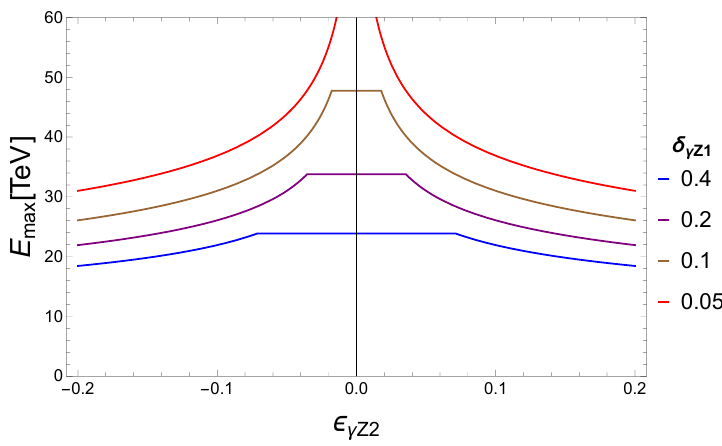
Figure 11 . The unitarity-violating scale from processes that depend on both δ γZ 1 and δ γZ 2 as function of the fractional deviation (cid:15) γZ 2 from the predictions of the dim-6 operator. See eqs. (4.15) and